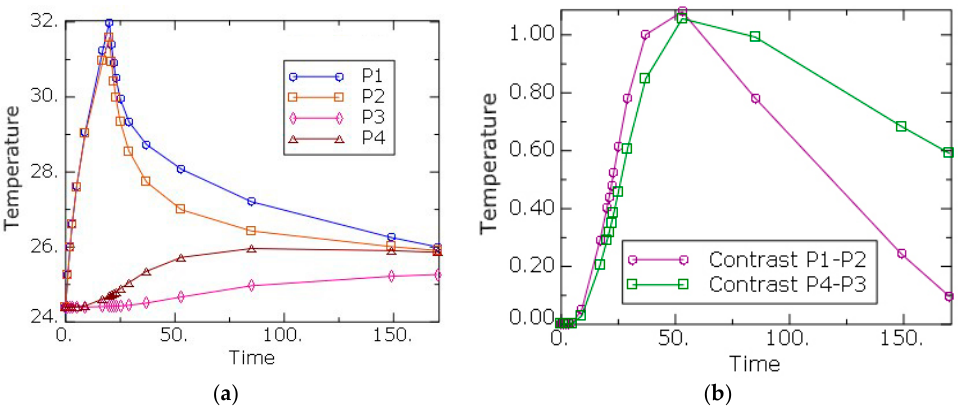
Figure 4. ( a ) Temperature vs. time at points P1 to P4 . ( b ) Temperature contrast curves P1 – P2 and P4 – P3 vs. time.